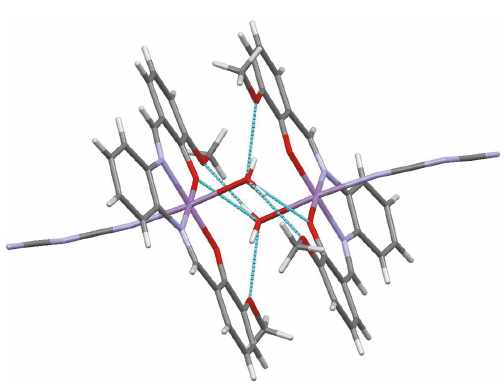
Figure 8: Stick diagram for the dimeric unit for complex 1 (man- ganese ion in magenta, oxygen in red, nitrogen in blue, and carbon in